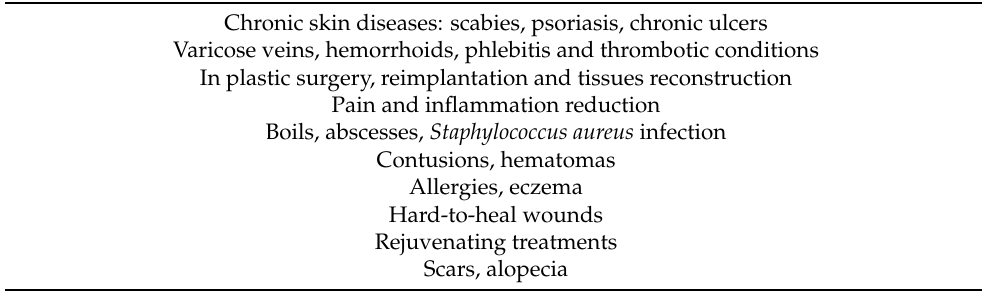
Table 2. Selected contraindications to the use of hirudotherapy [1,17–20]. Absolute Relative Haemophilia, coagulation factor deficiency diseases, anemia; Age below 10 years of age; Refusal of blood transfusions or therapy; Late old age; Pregnancy or breastfeeding; Menstruation; Tumors; High temperature; Sepsis; General weakness; Arterial failure, hypotension; Scarring; Unstable health condition, exhaustion of the body; Tuberculosis; Taking anticoagulants, NSAIDs, acetylsalicylic acid; HIV infection; Large blood loss. Mental